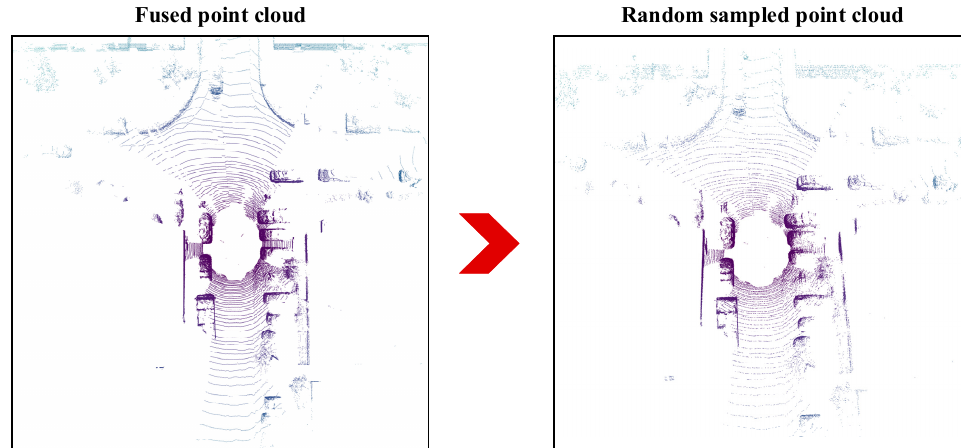
Figure 5. Result of random sampling of a fused point cloud. The point cloud became sparse after random sampling.